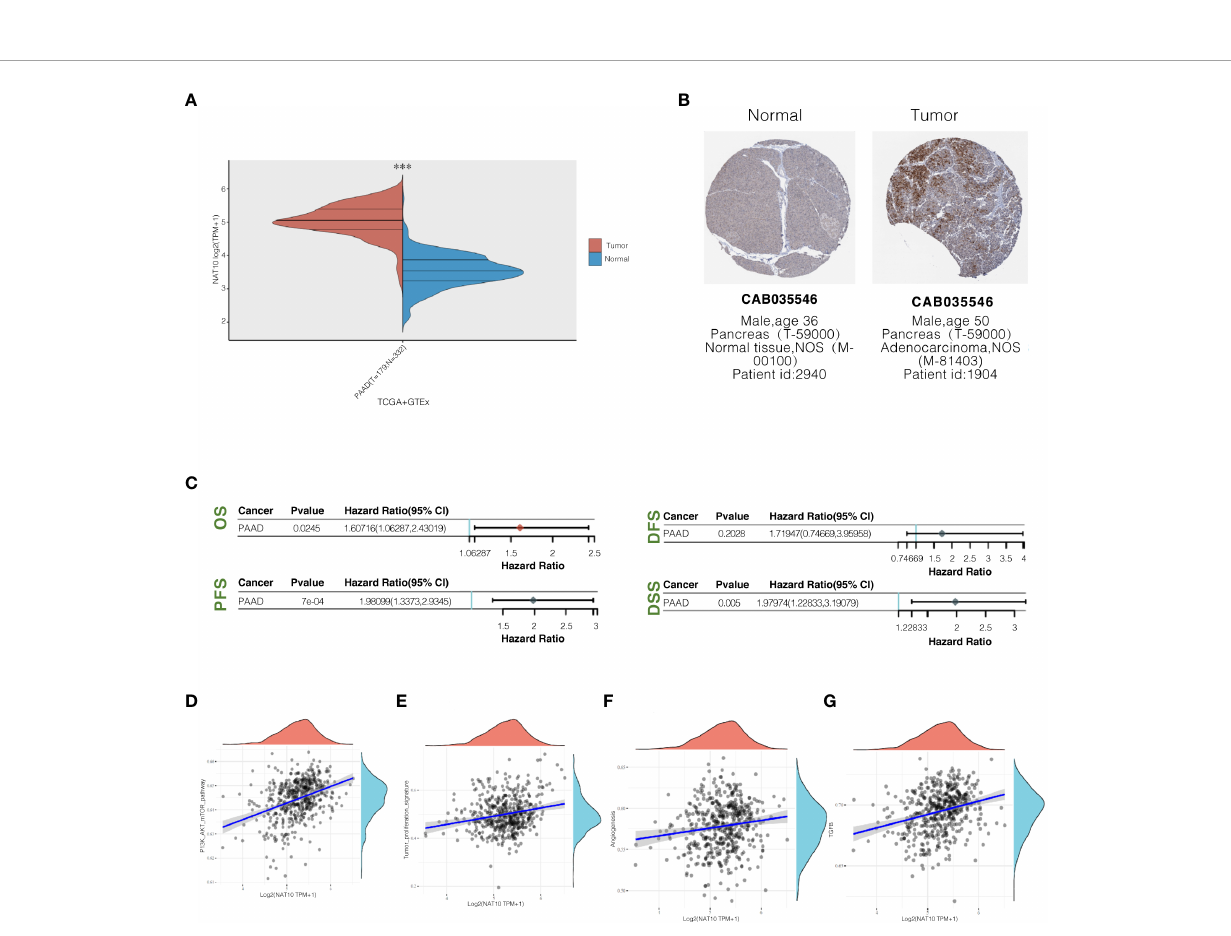
FIGURE 8 NAT10 expression levels in pancreatic ductal adenocarcinoma tissues and their relationship with prognosis. (A) Comparison of NAT10 expression levels in pancreatic ductal adenocarcinoma tissues and normal pancreatic tissues from TCGA and GTEx database sources; (B) The immunohistochemical staining of NAT10 in pancreatic ductal adenocarcinoma tissues and normal pancreatic tissues from the human protein atlas database. (C) Elevated NAT10 expression in the TCGA dataset predicts poor prognosis associated with patients. (D, E) Pathway correlation analysis of NAT10 positively correlates with the degree of PI3K-AKT activation and cell proliferation characteristics. (F, G) NAT10 positively correlates with TGF- b and angiogenic